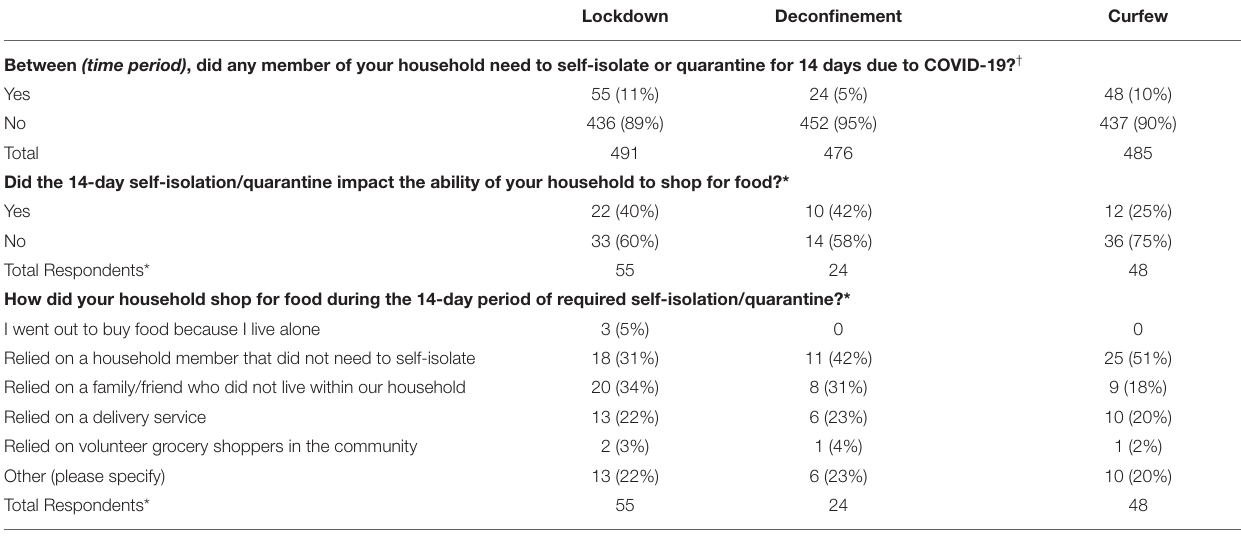
TABLE 5 | Food access during 14-day self-isolation.